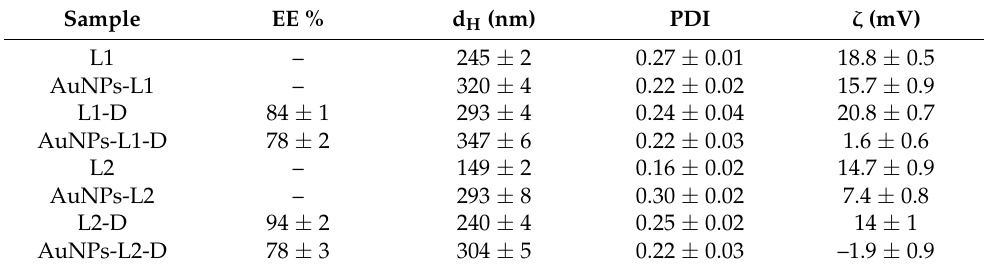
Table 2. Encapsulation efficiency (EE %), hydrodynamic apparent diameter (d H ), polydispersity index (PDI) and zeta potential ( ζ ) of both liposomal formulations with low (L1) and high (L2) cholesterol levels, loaded and unloaded with doxorubicin (D) and functionalized with AuNPs. Sample EE % d H (nm) PDI ζ (mV) L1 – AuNPs-L1 – L1-D AuNPs-L1-D AuNPs-L2